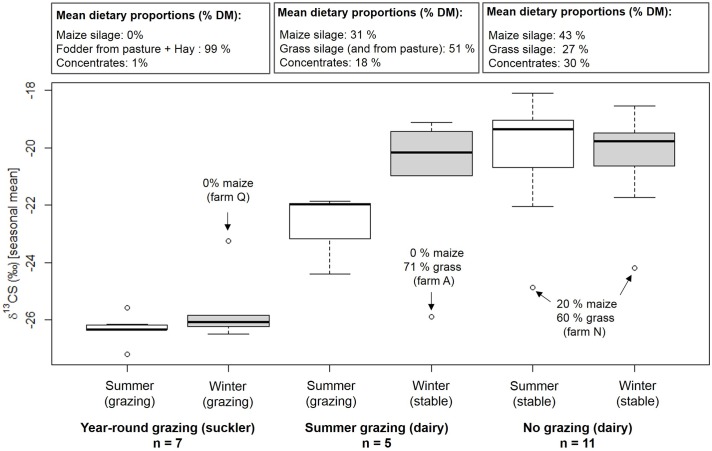
Box plots of δ13CS values of cattle hair sections analyzed for summer and winter of the three grazing regimes.The box represents the middle 50% of the data (between the 25th and 75th percentiles); the line in the box represents the median, the upper and lower lines represent the extreme values. Circles indicate outliers (>1.5 interquartile range) in the δ13CS value distributions within each season of each grazing regime. Annual dietary proportion (%) of maize, grass and concentrates are indicated in the three boxes above each grazing regime.